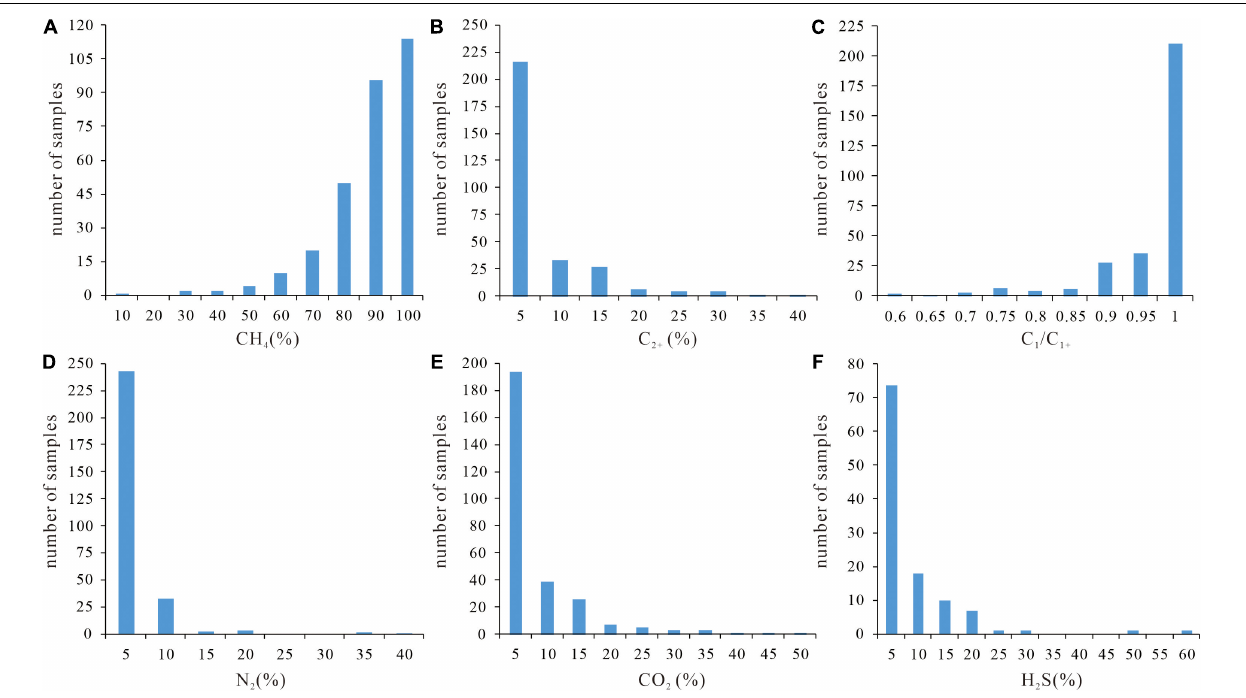
FIGURE 3 | Histogram of the content of CH 4 (A) , C 2 + (B) , C 1 /C 1 + (C) , N 2 (D) , CO 2 (E), and H 2 S (F) of the deep gases from Tarim and Sichuan basins. Data source see section “Samples and Methods” in the text.